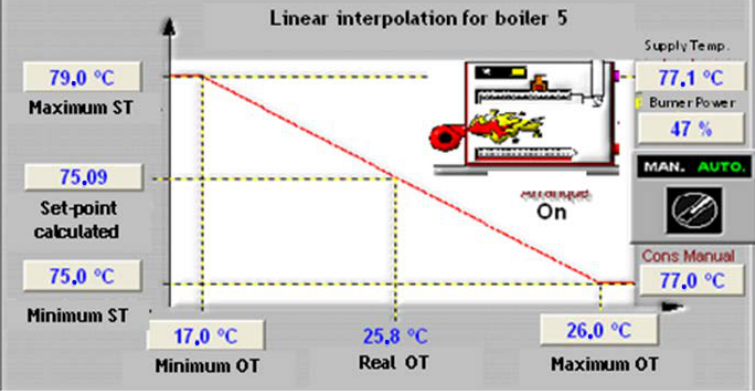
Figure 7. Boiler 5: Variable set point strategy for hot water supply temperature.